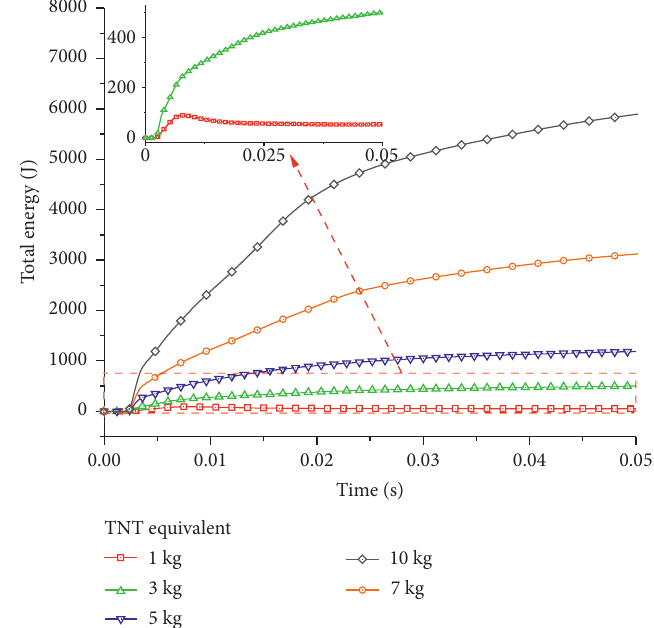
Figure 13: Total energy curves of pavements under different TNT equivalents.